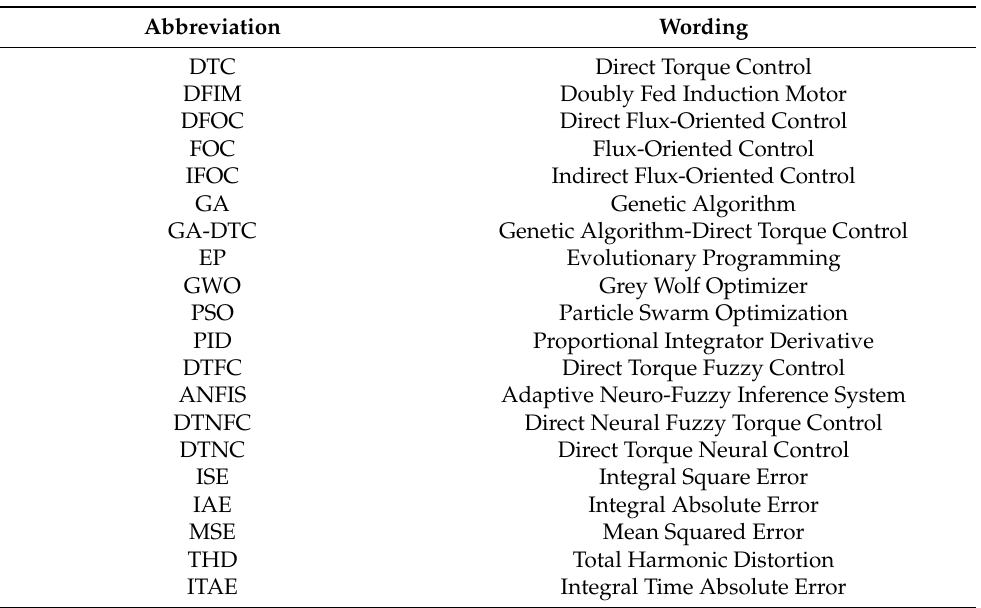
Table A4. Abbreviation